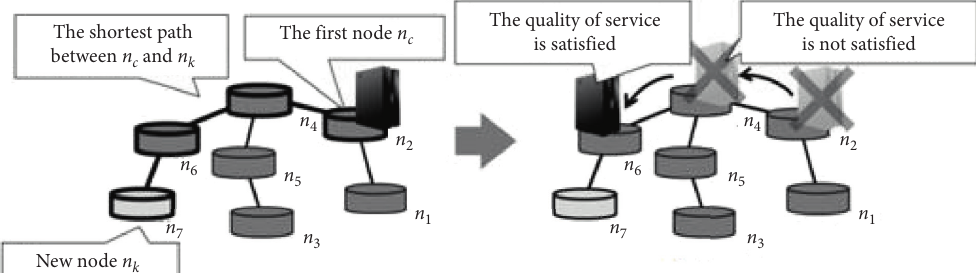
Figure 1: Virtual service resource replacement by moving the virtual network service by one hop.